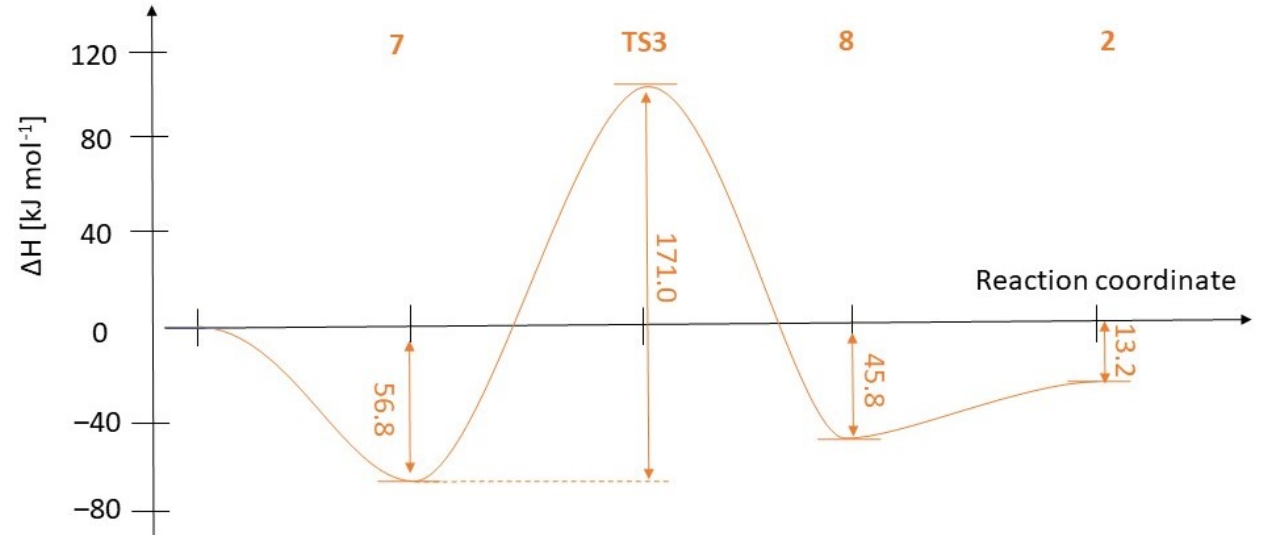
Figure 2. Enthalpy diagram for the monoesterification of ethylphosphonic acid ( 1B ) with BuOH in the presence of [bmim][BF 4 ].